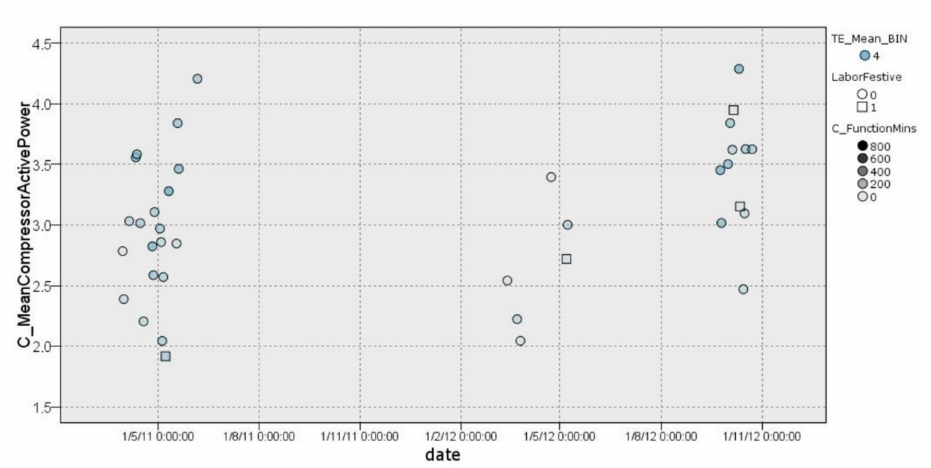
Figure 6. Graphical representation of distribution of cluster